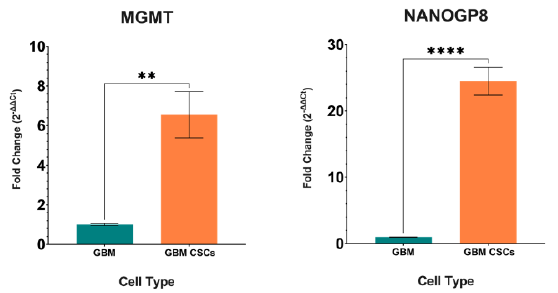
Figure 3. Fold change expression graphs for GBM and GBM CSCs. DNA repair gene MGMT and the CSC-specific gene NANOGP8 show significantly higher expressions in CSCs as compared to the GBM, which contains a mixed population of cancer cells along with CSCs. **: p < 0.01, ****: p <